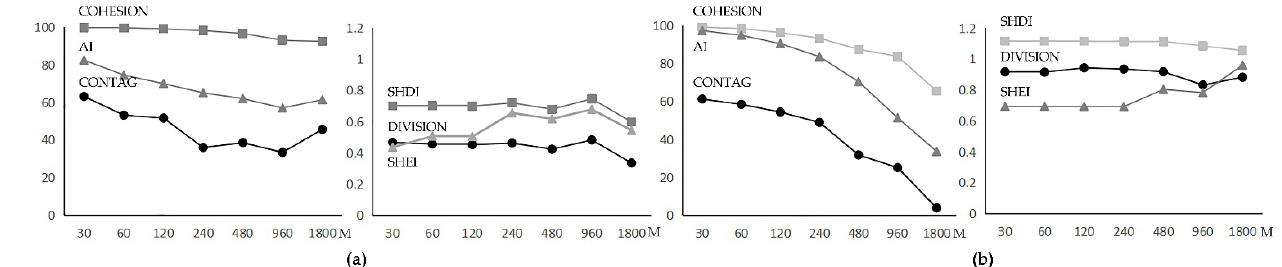
Figure 5. Spatial connectivity indices at different scales: ( a ) ecological connectivity index; and ( b ) recreation connectivity index.